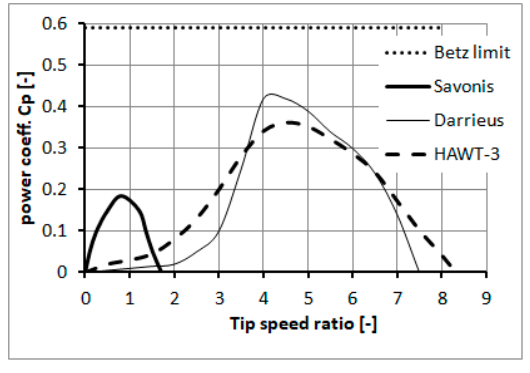
Figure 2. Power coe ffi cient. Figure 2. Power coefficient. Figure 2. Power coefficient.